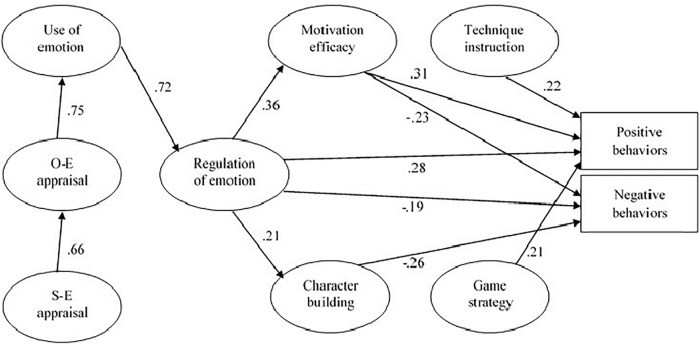
The path model. All the standardized path coefficients arc significant at the 0.05 level. Non-significant paths were excluded for visual simplicity.